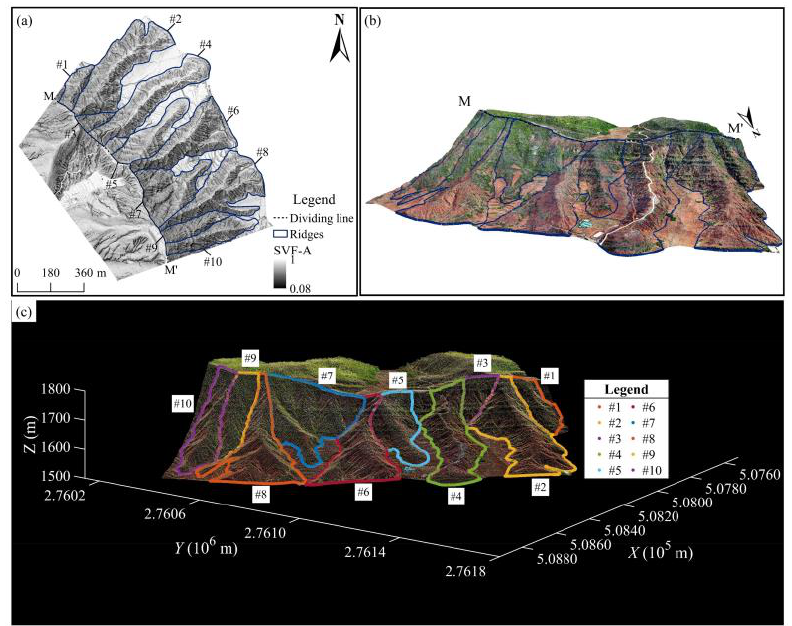
Figure 5. ( a ) Extraction of the ridges based on the SVF-A model, ( b ) display of the ridges combined with the 3D model, and ( c ) the 3D recognition result of the ridges. Table 3. Measurement results of morphological parameters of